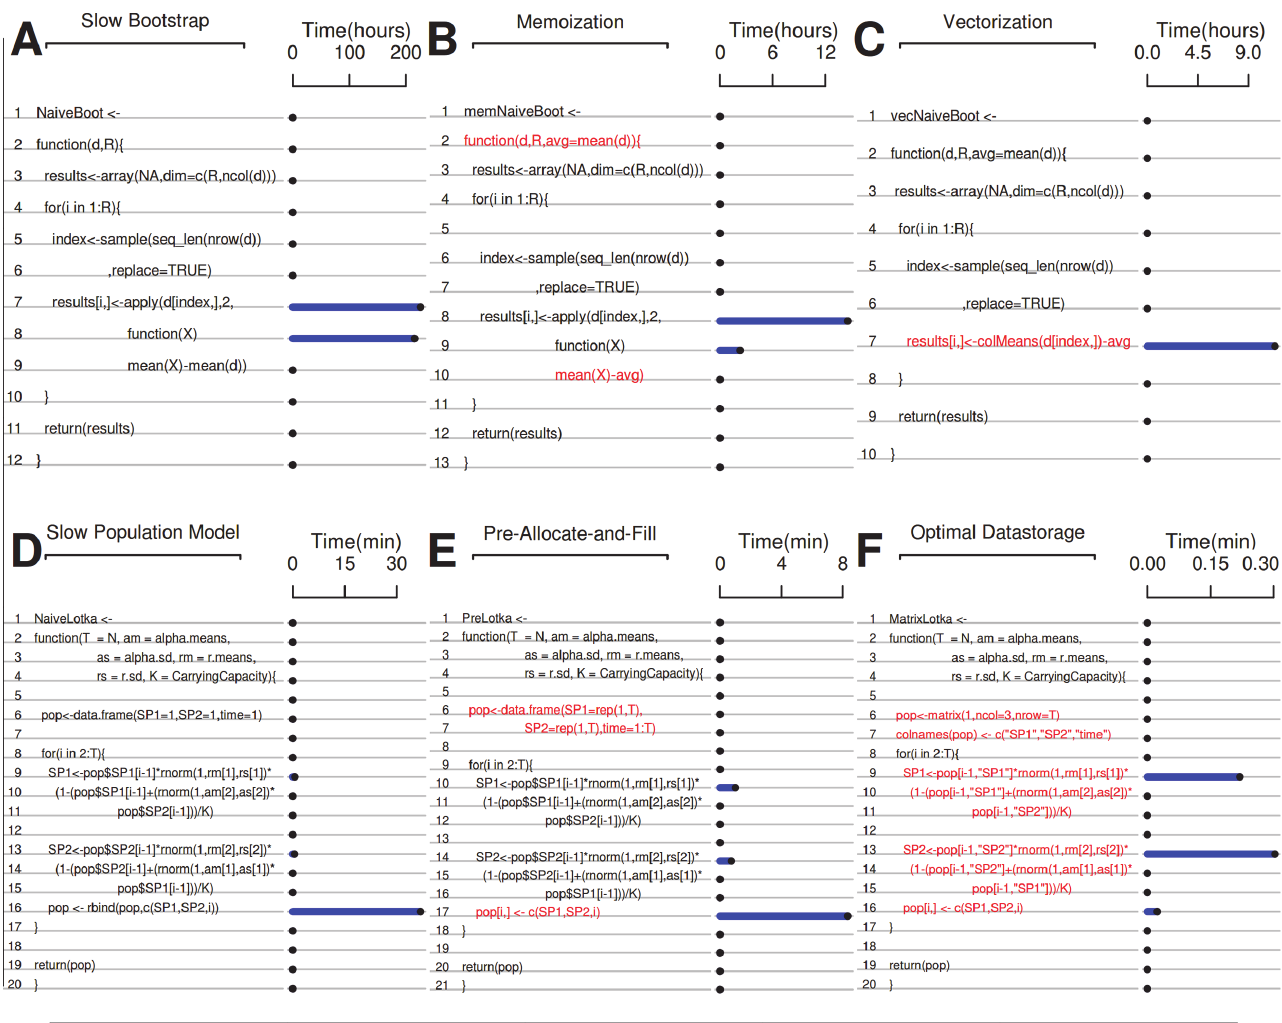
Fig 1. Visualization of profiling output using the aprof package for R code, where the amount of time spent in each line of code is indicated by the blue bars. In A, B and C, a bootstrap algorithm is shown, and in D, E, and F, a stochastic Lotka-Volterra competition model is shown. The consecutive optimizations described in the text are indicated with the red lines in B, C, E, and F indicating the altered pieces of code. (A) An inefficiently coded bootstrap algorithm, with most time spent in lines 7 – 8. This algorithm shuffles the values of a large matrix (750,000 x 1000) stored in object "d", and then calculates columnwise the difference between the mean column values and the overall mean. (B) A slightly improved code where the overall mean calculation is stored in object "avg." (C) A further improved version of the code where column means are calculated by a specialized and vectorized function ( colMeans ). (D) A slow running stochastic Lotka-Volterra model of species coexistence that runs a simulation over T years where species have normally distributed intrinsic growth rates (r * Norm(rm,rs)) and competition coefficients (a * Norm(am,as)). (E) the Lotka-Volterra model is more efficient when the pre-allocation-and-fill method is applied. (F) Switching to a matrix to store results further decreases run time. A detailed description of each optimization step with profiling analysis is given online (S1 Text, sections 2 and